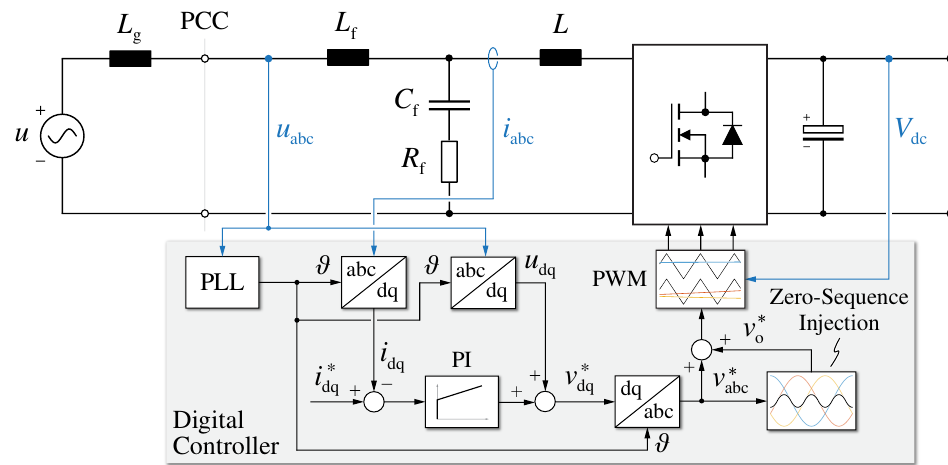
Figure 19. Simplified overview of the converter closed-loop current control: the digital controller schematic is highlighted in grey.